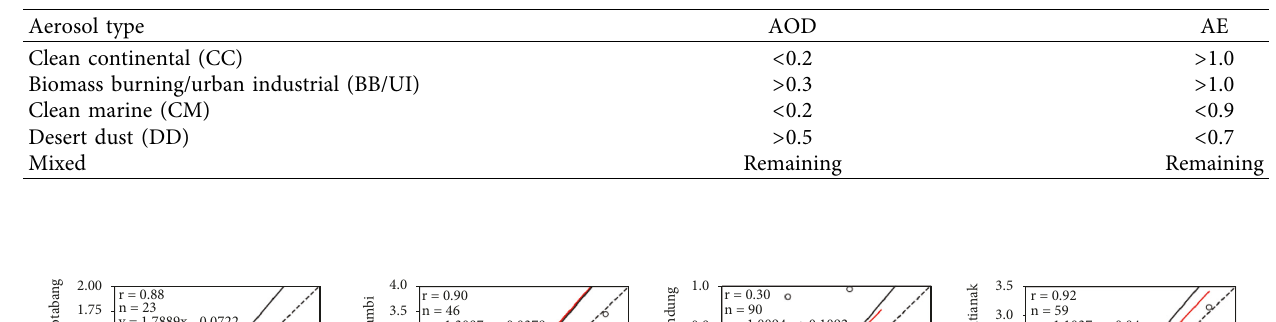
Table 1: Aerosol classification.